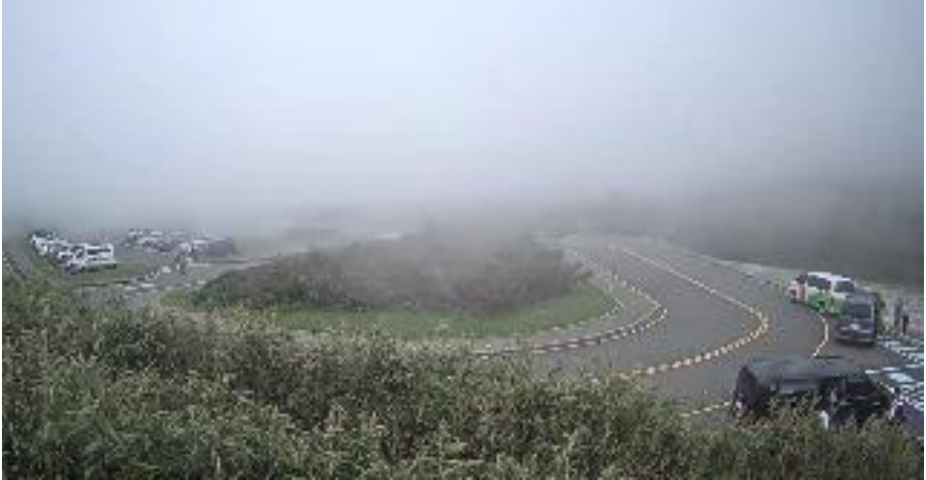
Figure 9. Sample image of haze scene.